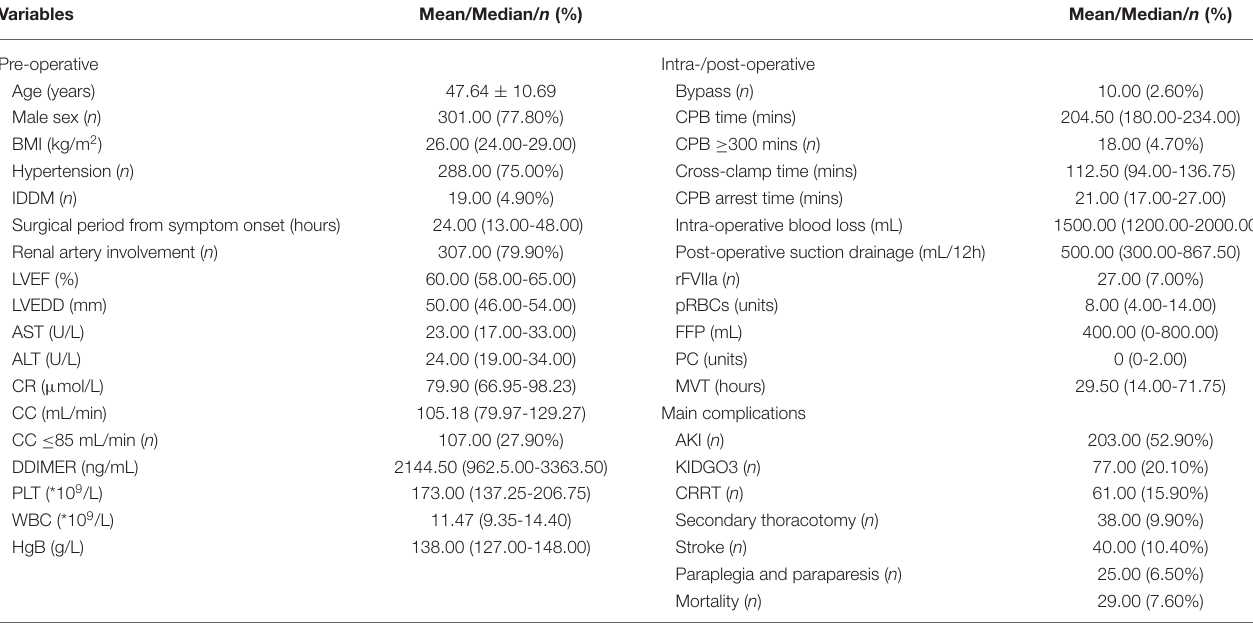
TABLE 1 | Baseline characteristics and perioperative data of the patients ( n =